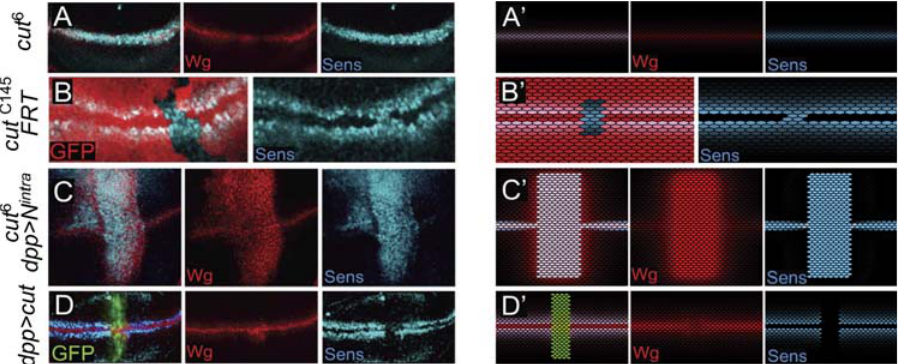
Figure 4. Refractoriness to Wg is conferred by the Notch target gene cut. (A) Mature cut 6 mutant wing disc showing co-expression of the proteins Senseless, Sens, (in blue) and Wg (in red) in boundary cells. (B) Clones of cells lacking cut activity marked by the absence of GFP (red). Sens (in blue) starts to be expressed in boundary cells. (C) Mature cut 6 mutant wing disc that expresses the intracellular domain of Notch (N intra ) under dpp Gal4 control. Wg protein expression is shown in red and Sens protein expression in blue. (D) Mature wing disc that expresses Cut and GFP (green) under dpp Gal4 control. Note the loss of Sens expression (blue) and ectopic expression of Wg (red) in non-boundary cells. (A’–D’) In silico counterparts of the results shown in